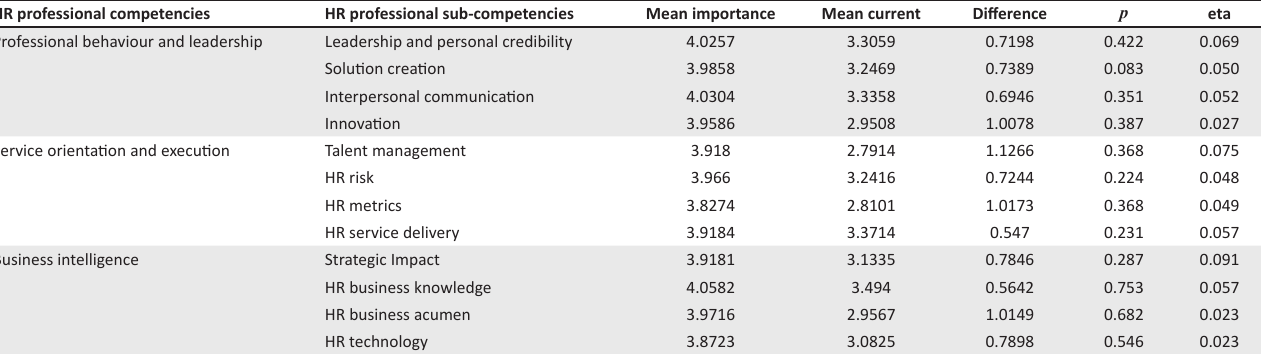
TABLE 3: Gap analyses: Current application versus the importance of human resource management